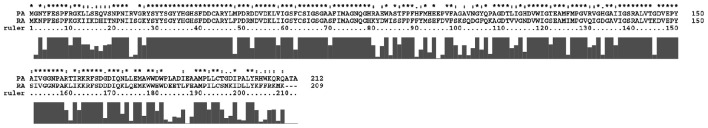
Sequence alignments of CAT from R. anatipestifer (RA) and P. aeruginosa (PA) using CLUSTAL X.